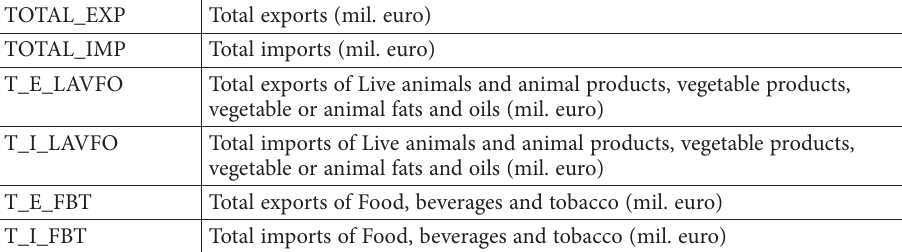
Table 1. Summary list of variables included in the research (source: authors based on NIS (2018) and NIS (2019)) TOTAL_EXP Total exports (mil.